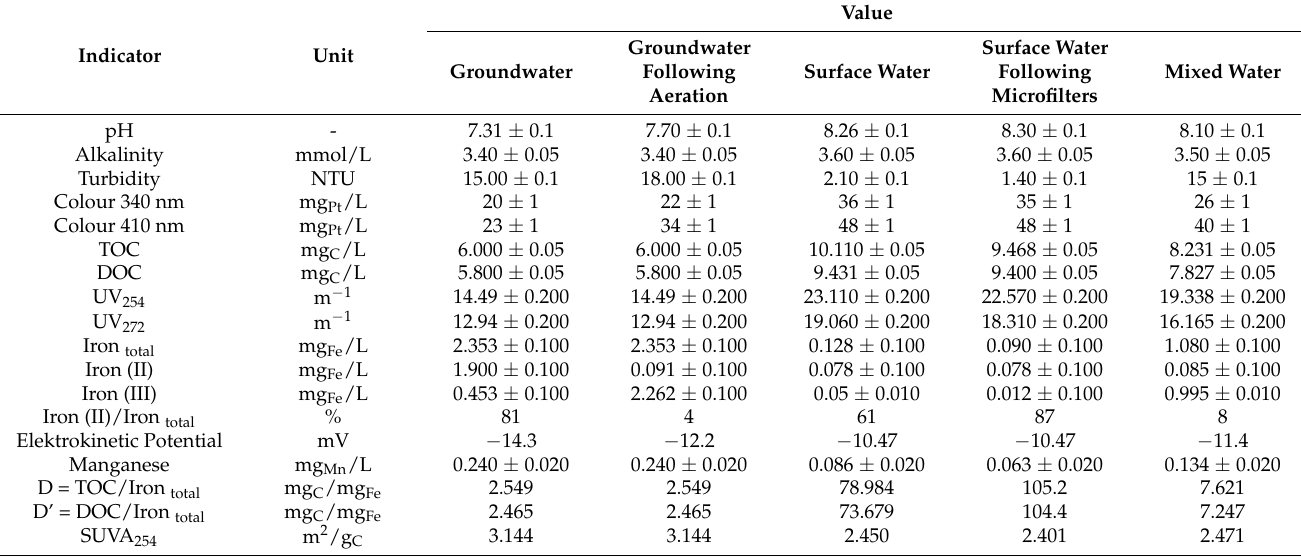
Table 1. Physical and chemical characteristics of water collected at the Zawada water treatment plant.